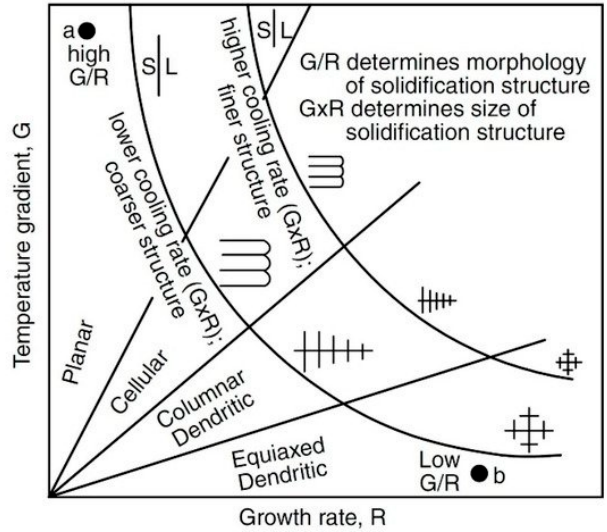
Figure 24. Effect of the temperature gradient and the solidification rate on the solidification micro- structures and grain dimension [127].